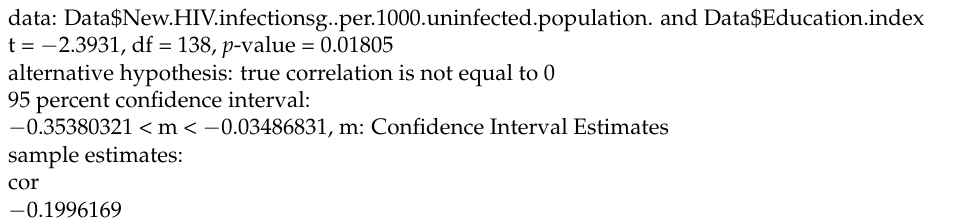
Table 13. STDs (HIV infection) infection rate according to education index. data: Data$New.HIV.infectionsg..per.1000.uninfected.population. and Data$Education.index